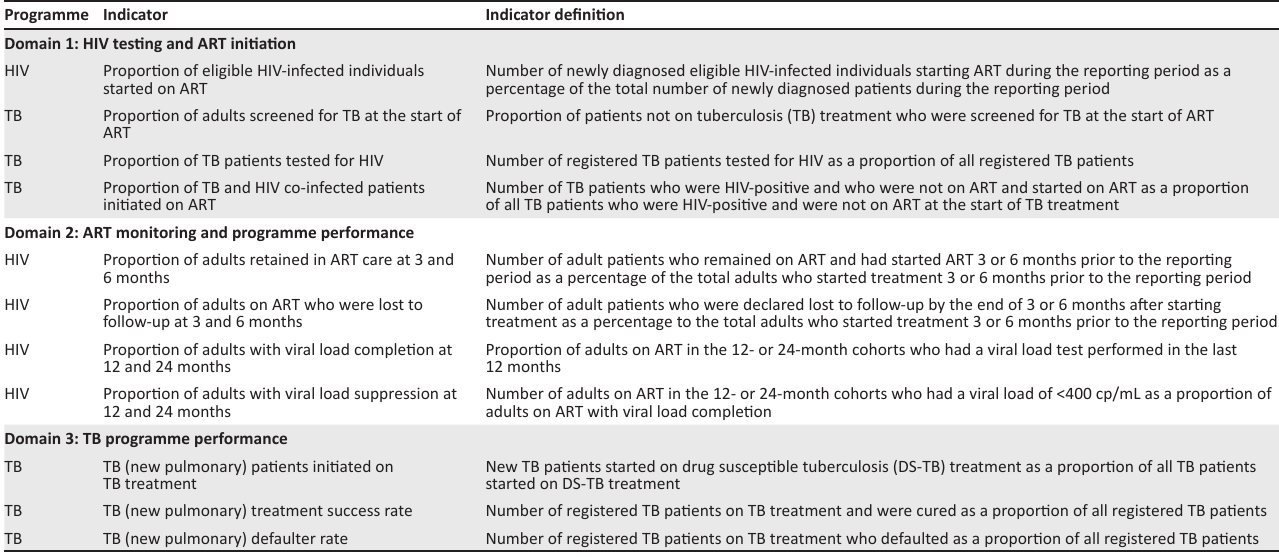
TABLE 3: Outcome measures. Programme Indicator Indicator